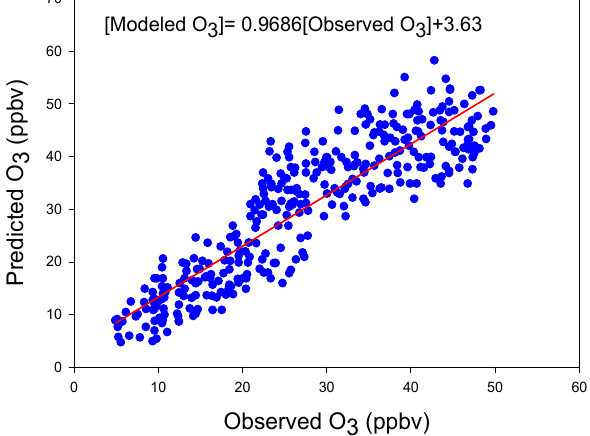
Figure 6. Correlation between predicted daytime O 3 concentration using neural model and observed daytime maximum O 3 concentration.